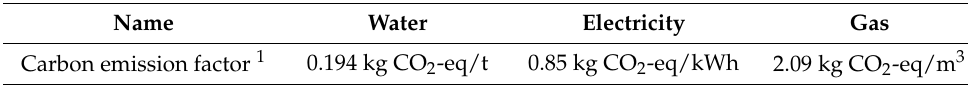
Table 4. Energy carbon emission